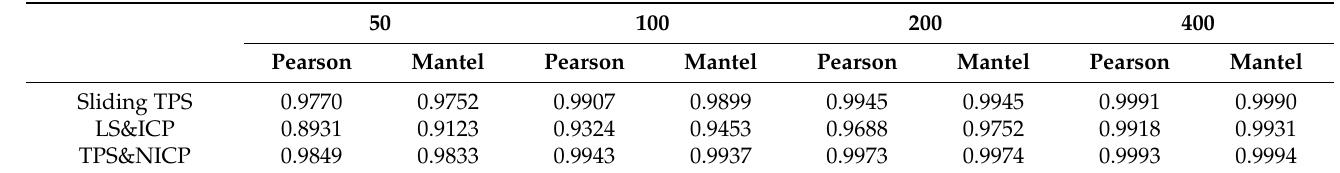
Table 5. Pearson correlations (all p < 0.001, parametric test) among vectors of Procrustes distances between each individual and the mean and Mantel tests comparing Procrustes distance matrices between each density of semilandmarking and the maximum density.